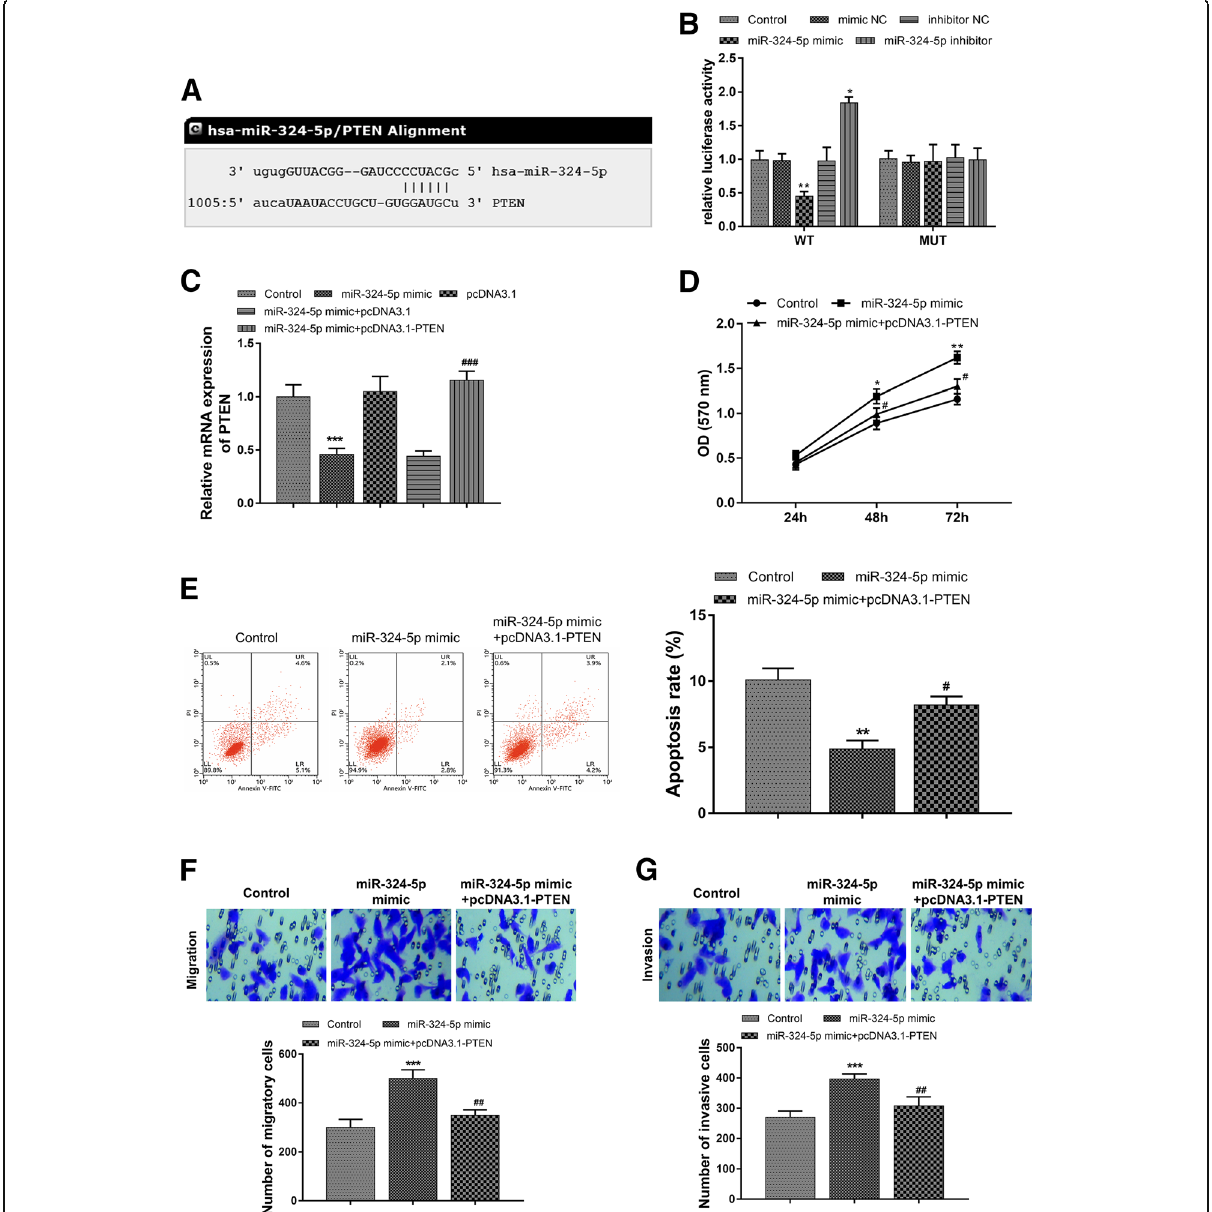
Fig. 4 PTEN directly mediated the regulatory effects of miR-324-5p on AGS cell proliferation, apoptosis, migration and invasion. a . The putative binding site of miR-324-5p at the 3 ′ -UTR of PTEN. b . The relative luciferase activity in AGS cells in the dual-luciferase reporter assay. c . The mRNA expression of PTEN was inhibited by miR-324-5p overexpression, and the pcDNA3.1-PTEN could reverse this effect. d-g . The promoted cell proliferation, inhibited cell apoptosis and enhanced cell migration and invasion induced by miR-324-5p overexpression were all abolished by the upregulation of PTEN in AGS cells. * P <0.05, ** P <0.01, *** P <0.001 compared to control group; # P <0.05, ## P <0.01 compared to miR-324-5p mimic